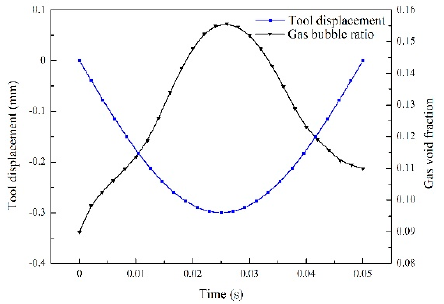
Figure 6. Average gas void fraction and tool displacement as a function of time during one half-period of tool vibration.